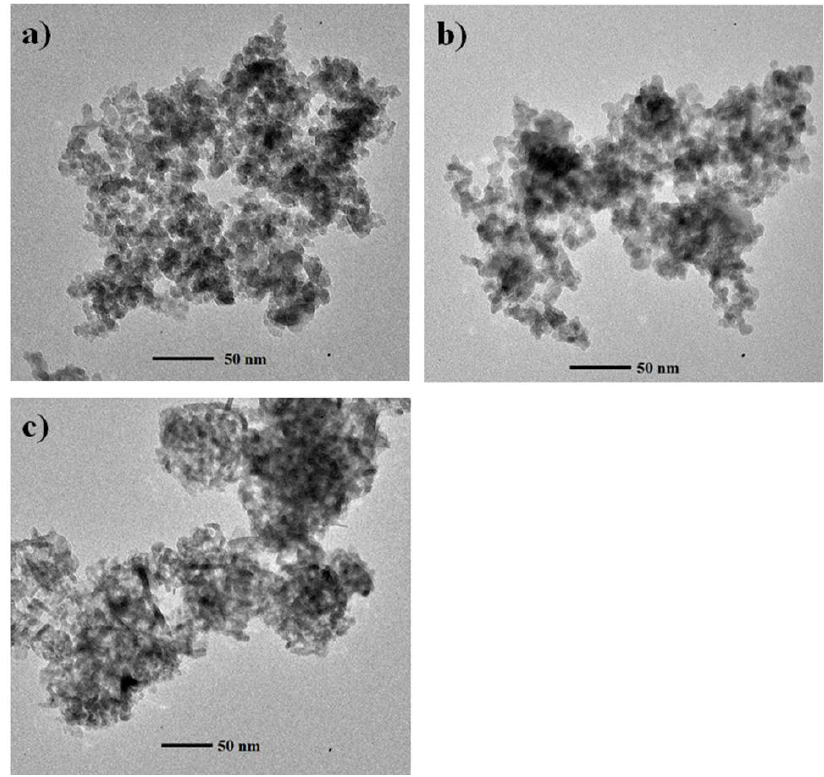
Figure 2. Bright field transmission electron microscopy (TEM) images of γ-Al 2 O 3 NPs in size of: ( a ) 5 nm; ( b ) 10 nm; and ( c ) 20–30 nm.